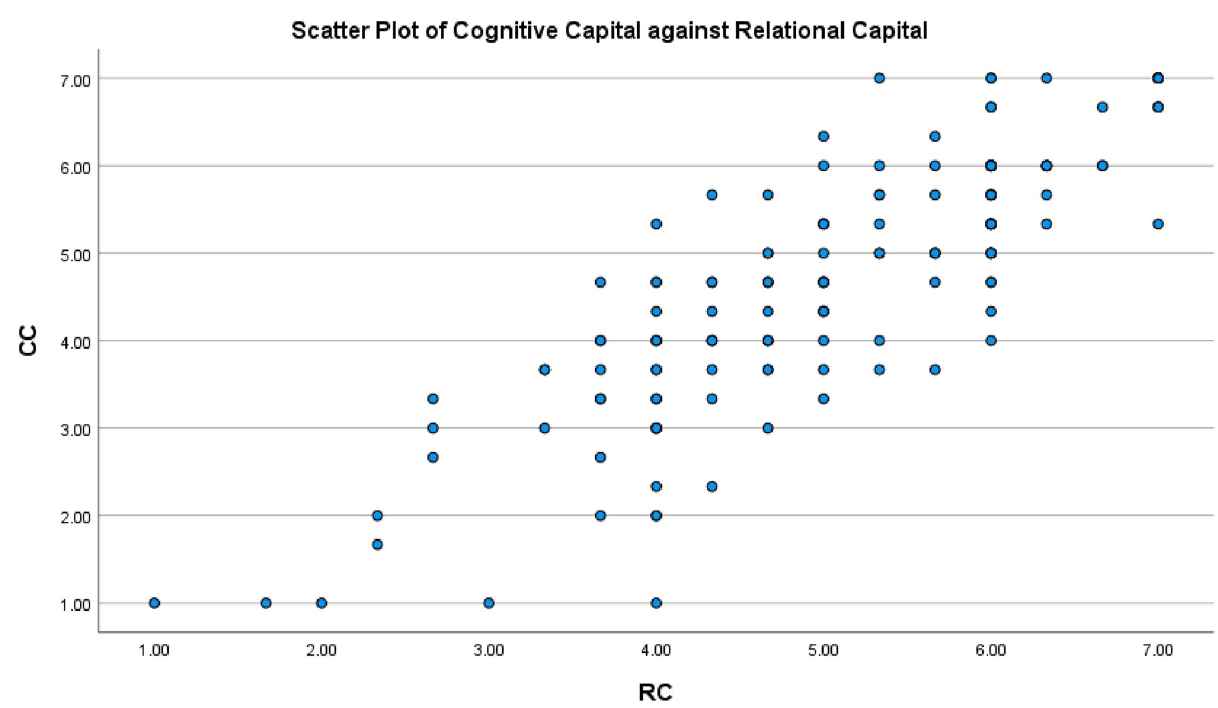
Fig 4. Scatter plot between the cognitive capital and relational capital.